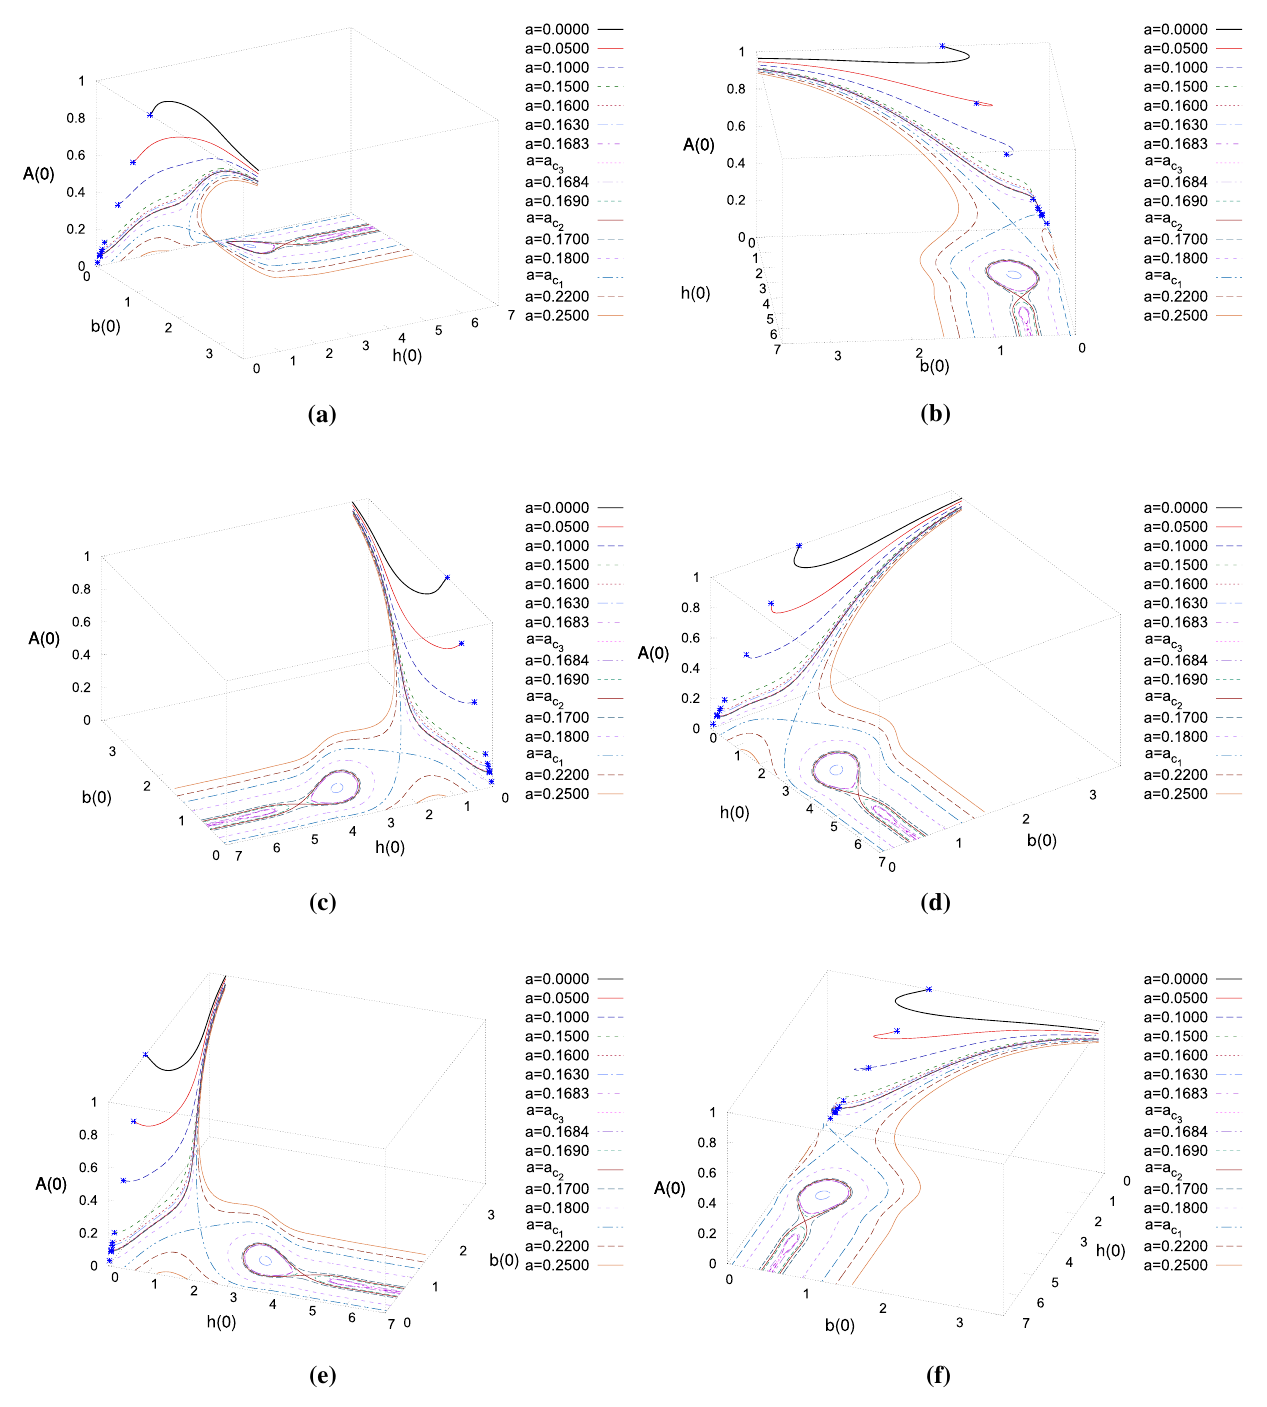
Fig. 3 a – f The 3D phase diagram (for different viewing angles) of h ( 0 ) and b ( 0 ) versus A ( 0 ) for a set of values of a in the range a = 0 . 0 to a = 0 . 2500. The viewing angles are denoted by (θ,φ) , where θ is the angle of rotation about the ox -axis in the anticlockwise direction, Figure 4a–f correspond, respectively, to the values of the viewing angles (θ, φ) ≡ ( 60 , 100 ), ( 115 , 15 ), ( 60 , 200 ), ( 40 , 240 ), ( 140 , 60 ) and ( 130 , 40 )